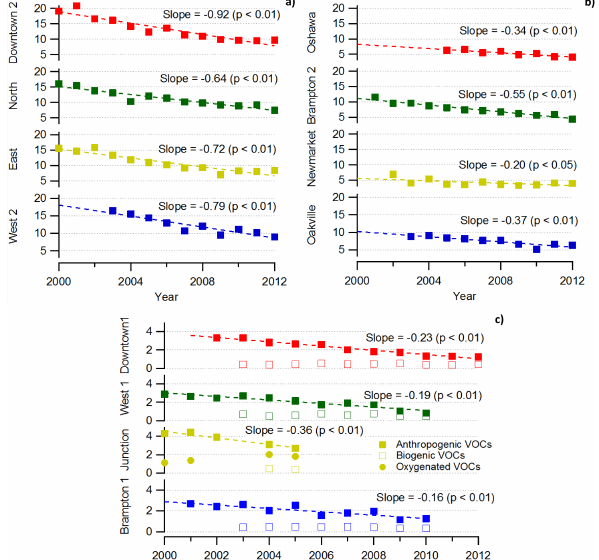
Figure 2. Annual summer midday NO 2 concentrations (ppb) in GTA urban (a) and suburban (b) areas; slopes in ppb year − 1 . An- nual summer VOC reactivity (s − 1 ) (c) ; slopes in s − 1 year − 1 . Figure 3. Annual summer average maximum 8h O 3 – (a) and (b) – and O x – (c) and (d) – concentrations (ppb) for Toronto urban and suburban areas; slopes in ppbyear − 1